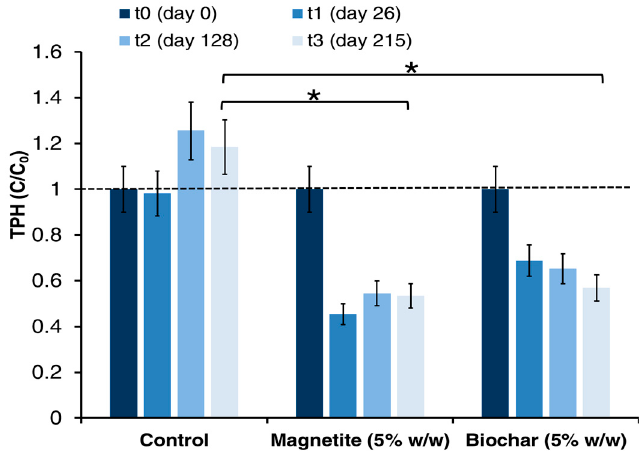
Figure 3. Total petroleum hydrocarbon (TPH) concentration over time in the different treatments. Error bars indicate the standard error of replicated samples. Significant differences were determined by two-tailed Student’s t -tests (* corresponds to p < 0.05).